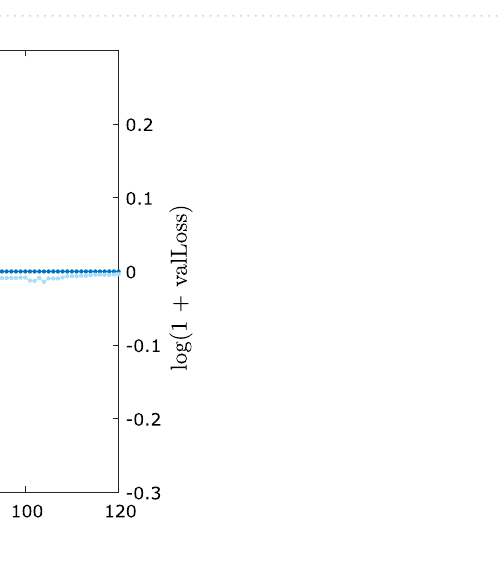
Figure 3. Two-dimensional and three-dimensional partial dependency plots show the predictor sensitivity of all possible predictor pairs. The histogram along the x and y-axis of the two-dimensional plot shows the distribution of the predictor and the response variable, respectively.